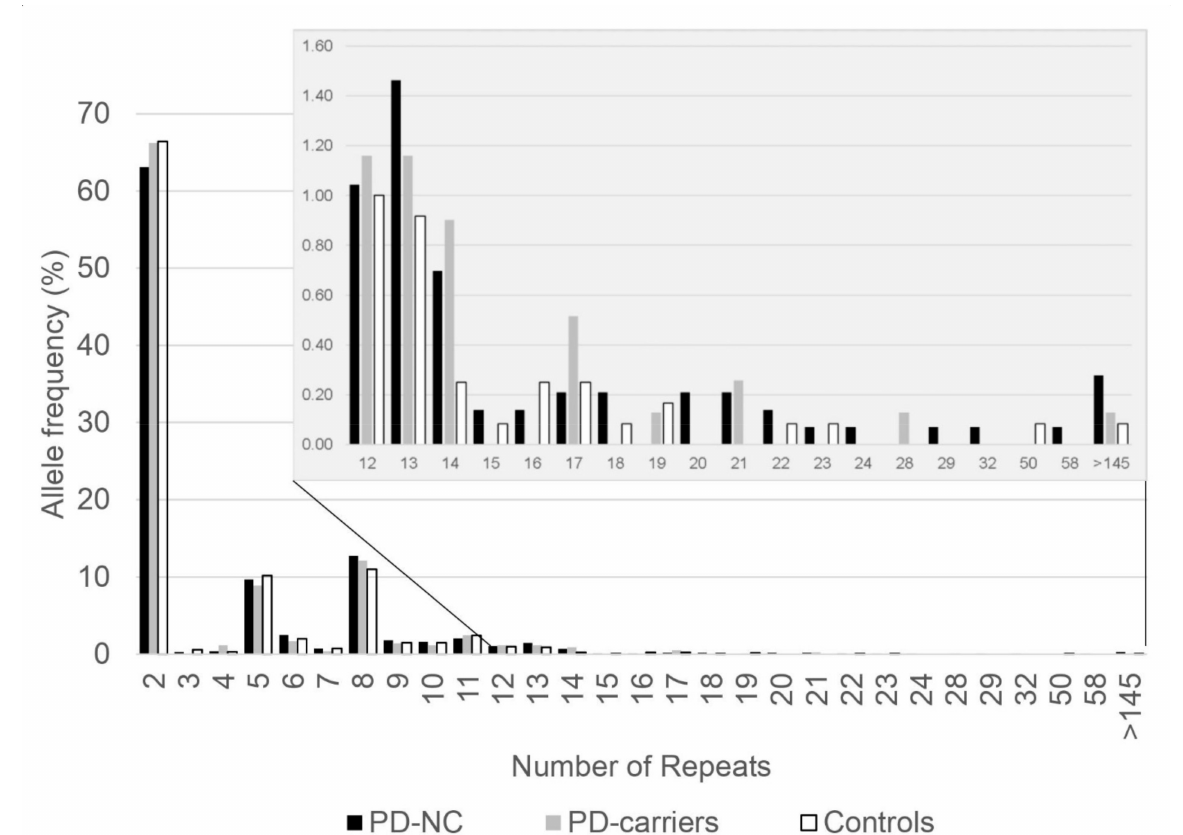
Figure 1. Graphic representation of C9orf72 G 4 C 2 hexanucleotide repeat allele frequencies in Ashkenazi Parkinson’s disease patients and controls. The repeats’ allele frequencies for each group are presented: PD patients without LRRK2 , GBA , and SMPD1 mutations (PD-non-carriers, black); PD patients carrying mutation in LRRK2 , GBA , or SMPD1 (PD-carriers, gray); and controls as previously published (Reference [26], white). Upper panel is a zoomed-in graph of 12 repeats and